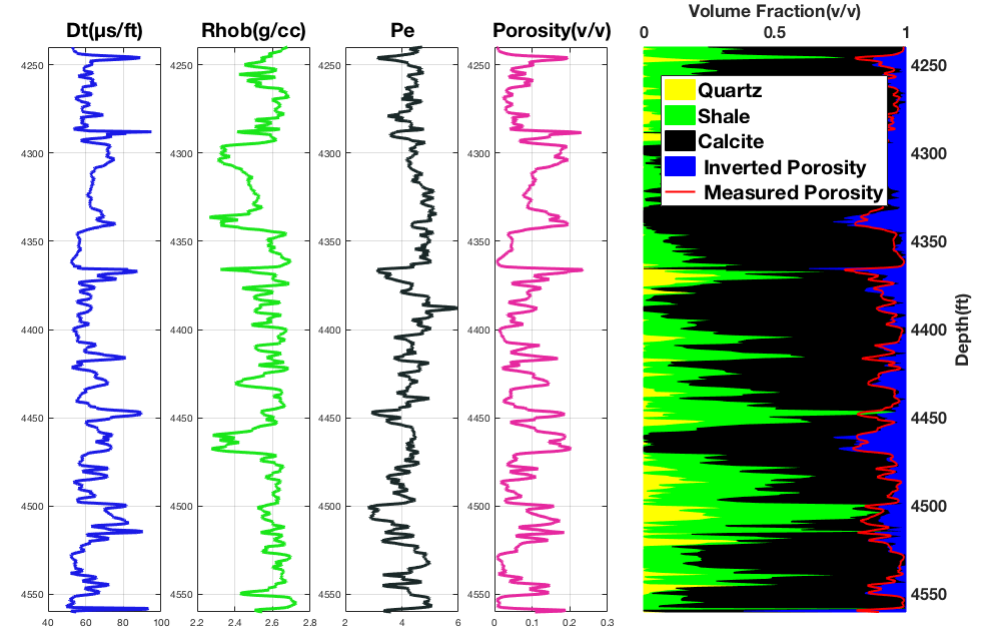
Figure 5. Composition analysis of geophysical well logs, late Atokan and early Desmoinesian (Cherokee group), Middle Pennsylvanian, Kansas, calculated using the Moore-Penrose generalized inverse method. A good match can be observed between the inverted and measured porosity.